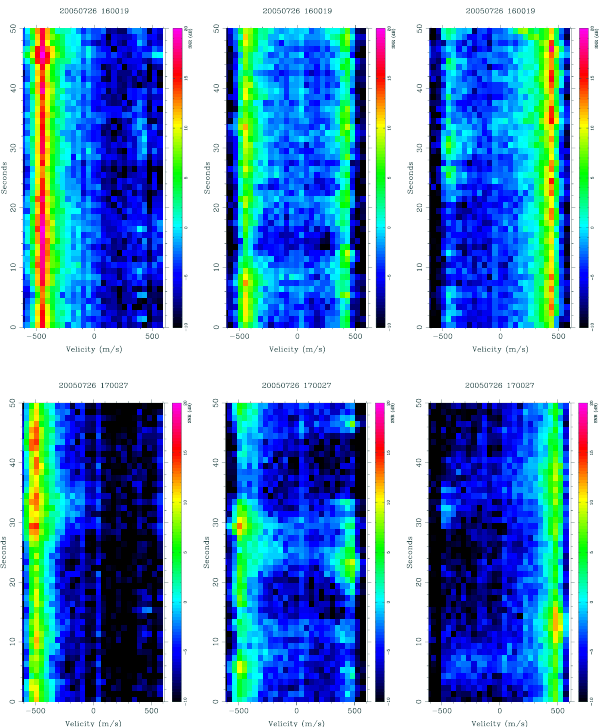
Fig. 9. Height-averaged spectrograms representing 50s intervals of AMISR prototype observations, running from bottom to top. The left, center, and right columns correspond to − 24 ◦ , 0 ◦ , and 24 ◦ east zenith angles. The top and bottom row correspond to start times of 11:02 LT and 12:02 LT,